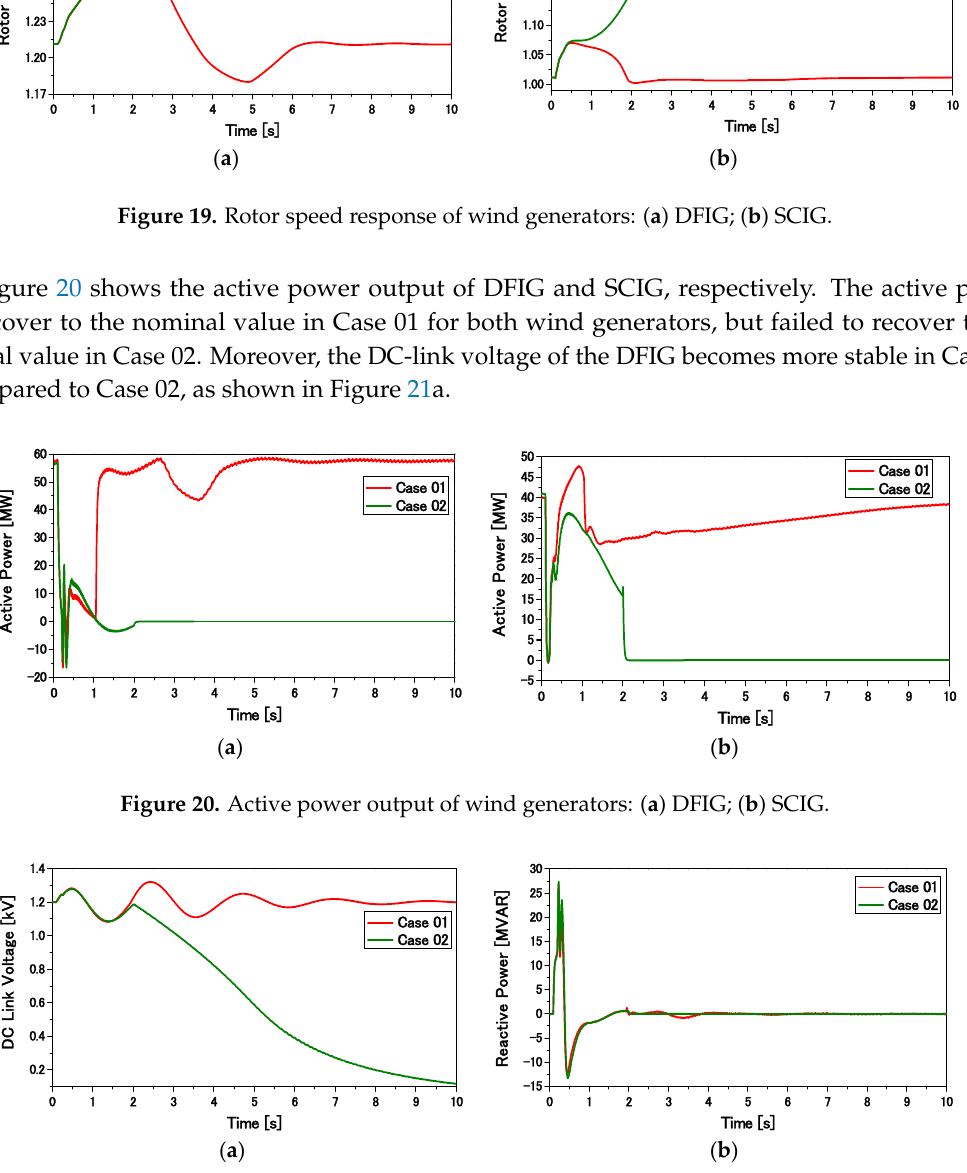
Figure 21. Individual responses of the DFIG: ( a ) DC ‐ link voltage; ( b ) reactive power output of GSC. Figure 22a,b show the active power output and rotor speed responses, respectively, of the conventional power plants (SGs). The active power and rotational speed of the SGs can return to the initial condition in Case 01. However, the active power of the SGs in Case 02 increases significantly after the WF has been disconnected, resulting in a rotor speed drop of the SGs. It is clear that the system becomes unstable in Case 02, which can also be seen from Figure 23, where the system frequency collapses in Case 02 after the WF has been disconnected.